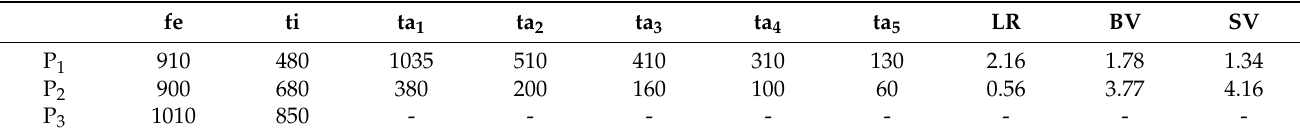
Table 5. Lengths (in µ m) and proportions of legs of Rheotanytarsus photophilus Goetghebuer, 1921, adult male ( n =